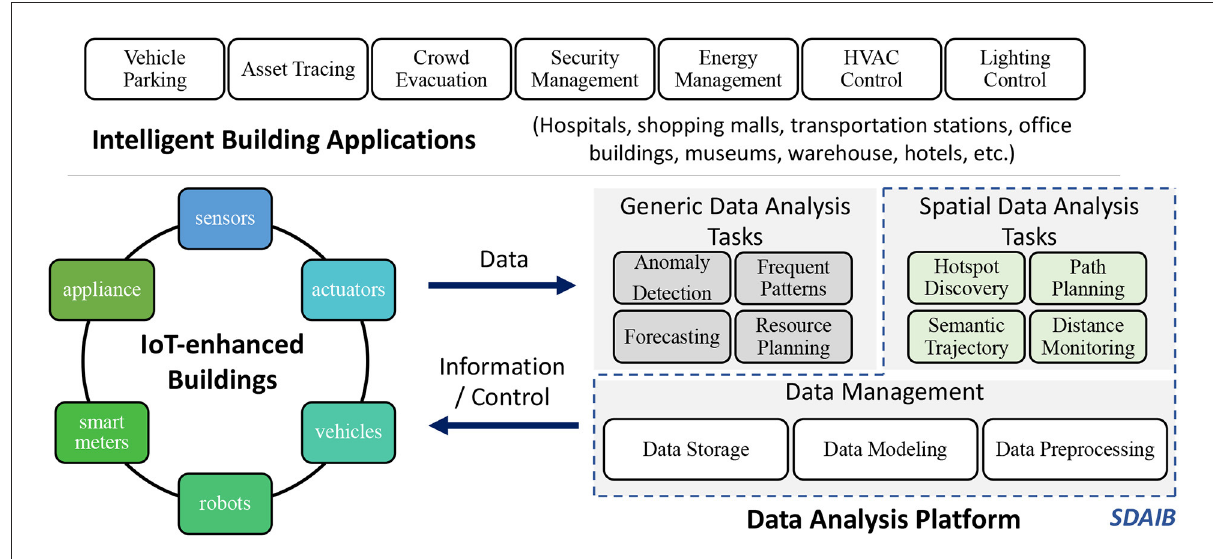
FIGURE1 An overall picture of intelligent buildings: IoT devices, data analysis, and